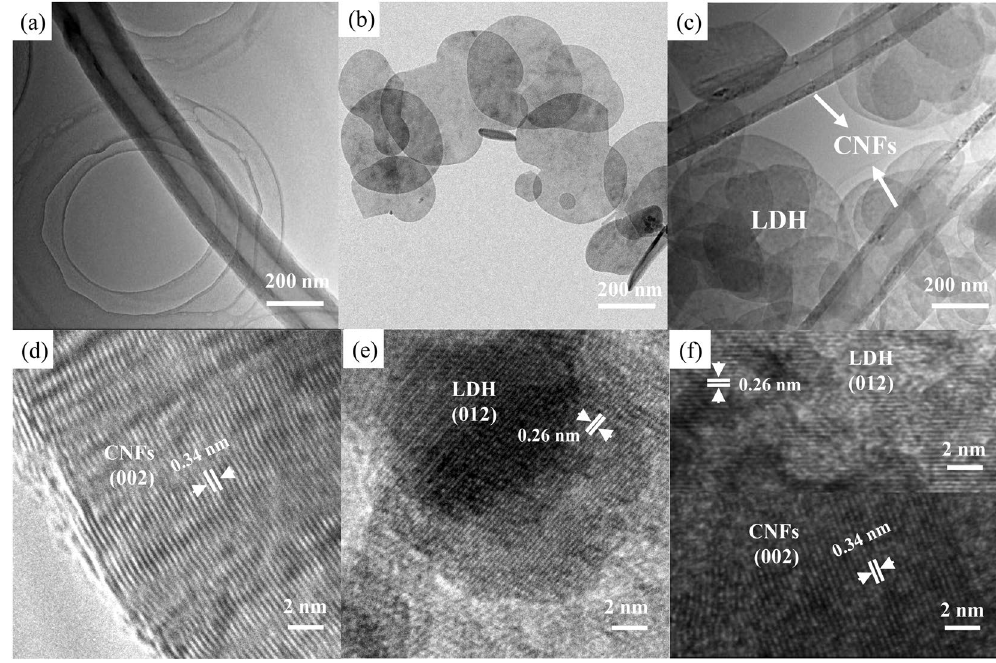
Figure 3. ( a ) TEM image of original CNFs; ( b ) TEM image of the CoNiFe-LDH; ( c ) TEM image of the CoNiFe- LDH/CNFs-0.5 composite; ( d ) HRTEM image of the original CNFs; ( e ) HRTEM image of the CoNiFe-LDH and ( f ) HRTEM image of the CoNiFe-LDH/CNFs-0.5 composite.